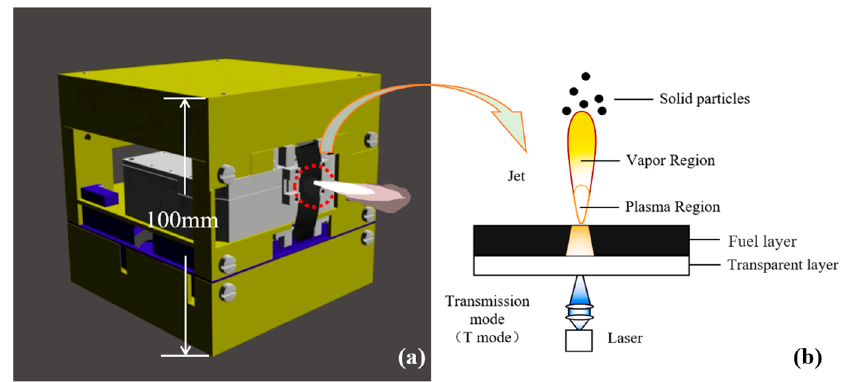
Figure 1. ( a ) The three-dimensional structure of the cube laser ablation micro-thruster; ( b ) The laser ablation principle of transmission mode. Reprinted with permission from [19]. Copyright 2022, IOP Publishing.